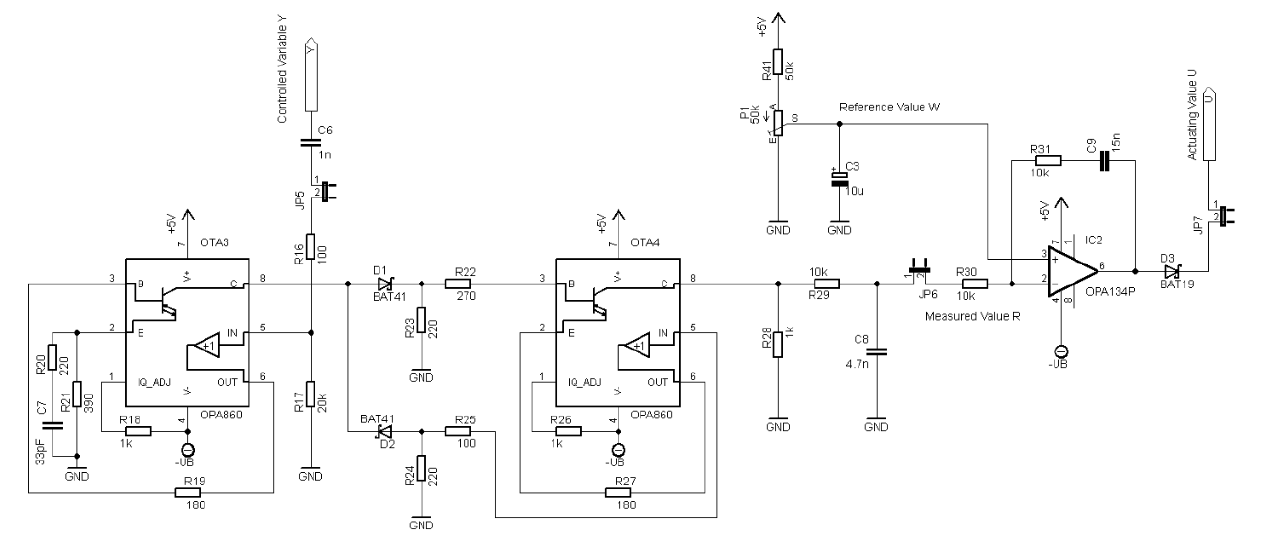
Figure 8. Back-end of our QCM circuit with the reference value W , the PI-controller IC2, and the rectifier (around D1, D2, OTA3, and OTA4) that generates the measured value R .